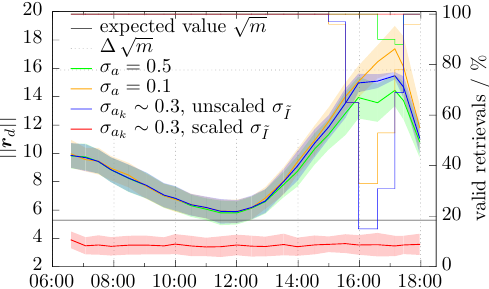
Fig. 15. Data residuals as in Fig. 7, but here for the regularised cases of Fig. 14 (thick lines). Also shown is the percentage of valid re- trievals according to Eq. (17) (thin